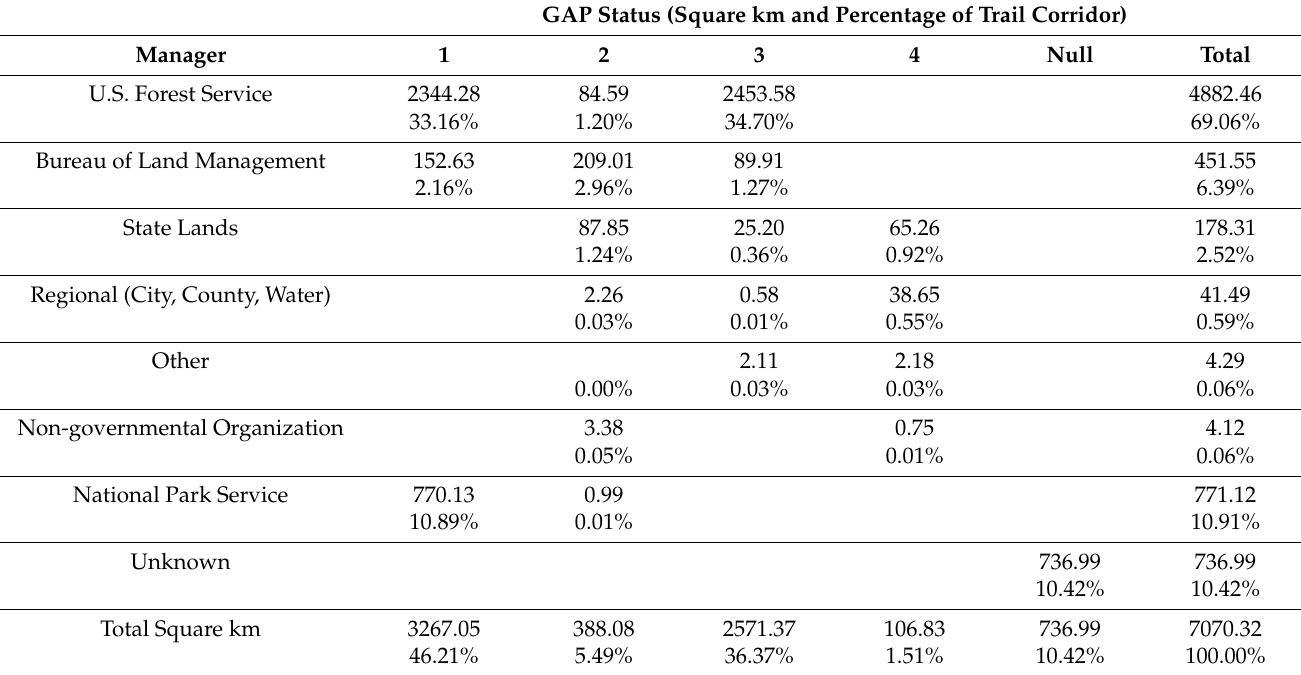
Table 4. GAP status and land managers of the Pacific Crest Trail corridor. GAP Status (Square km and Percentage of Trail